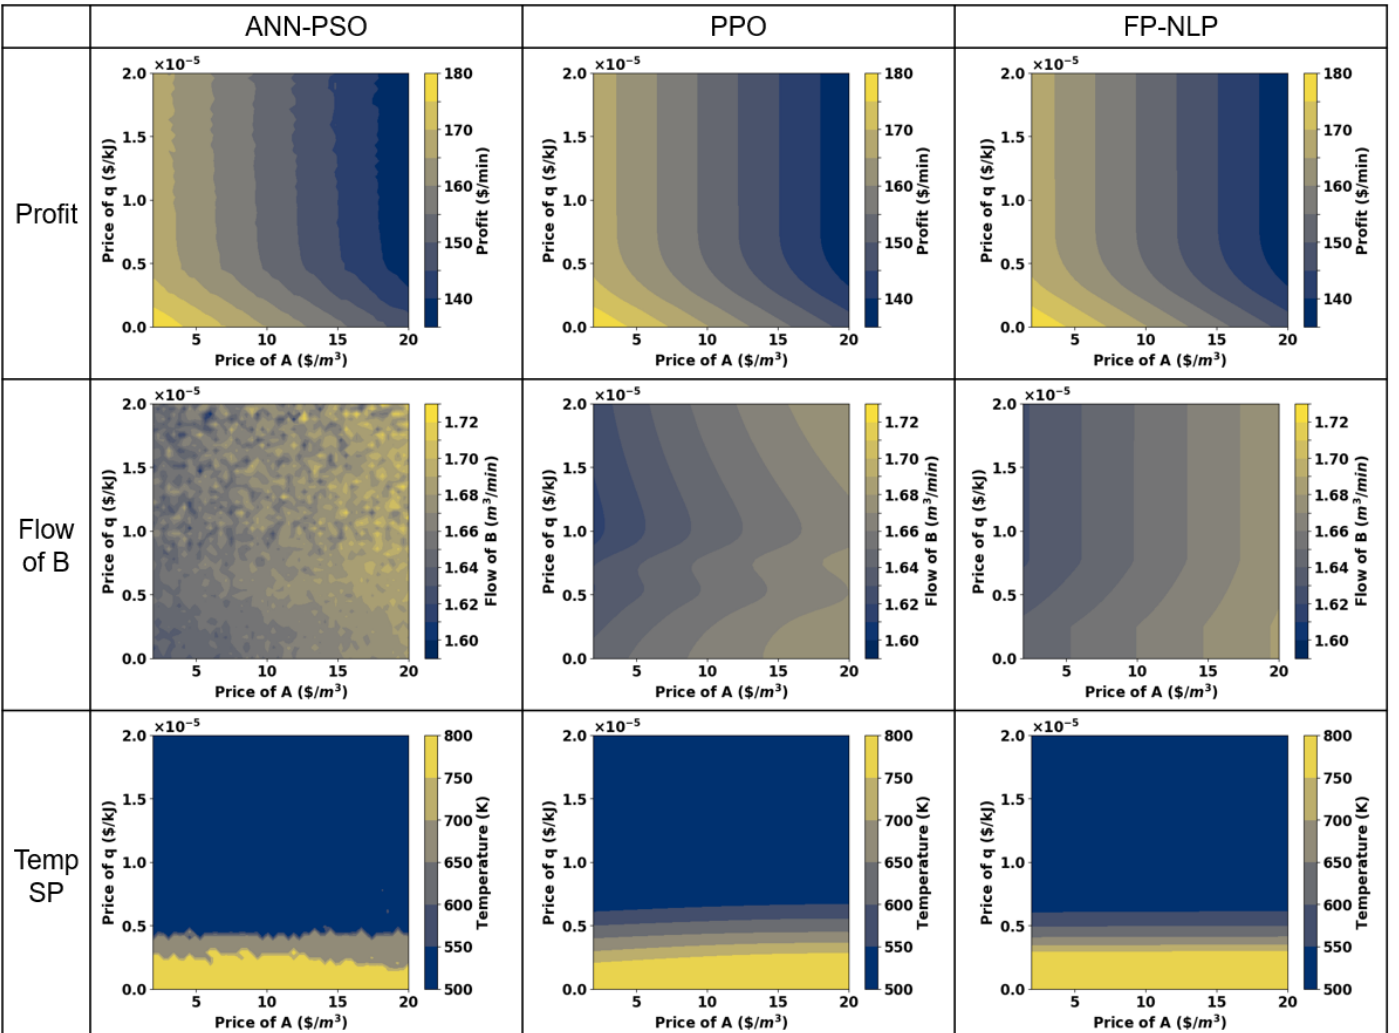
Figure 7. Contour plots for methods’ profits, flows of B, and temperature set points over prices of A and